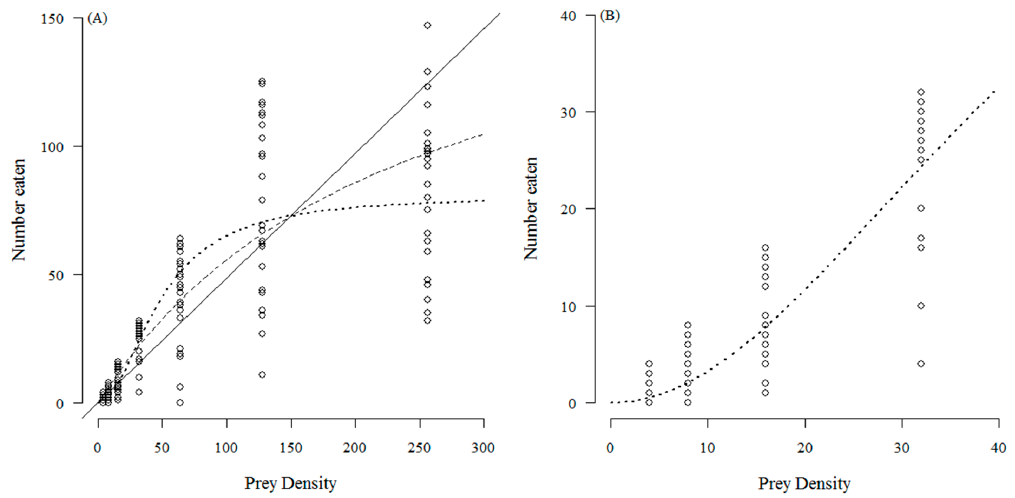
Figure 2. Number of T. absoluta eggs eaten during 24 h by the mirid predator E. varians when offered four, eight, 16, 32, 64, 128 and 256 eggs. The dotted curve—a type III functional response—describes the data best. The drawn line represents the fit for a type I response, and the dashed curve for a type II response. The open circles represent the values found for each replicate; 25 replicates were done for each prey density; ( A ) shows the full range of tested densities; ( B ) shows the curve at the four lowest densities to confirm the sigmoidal functional response.